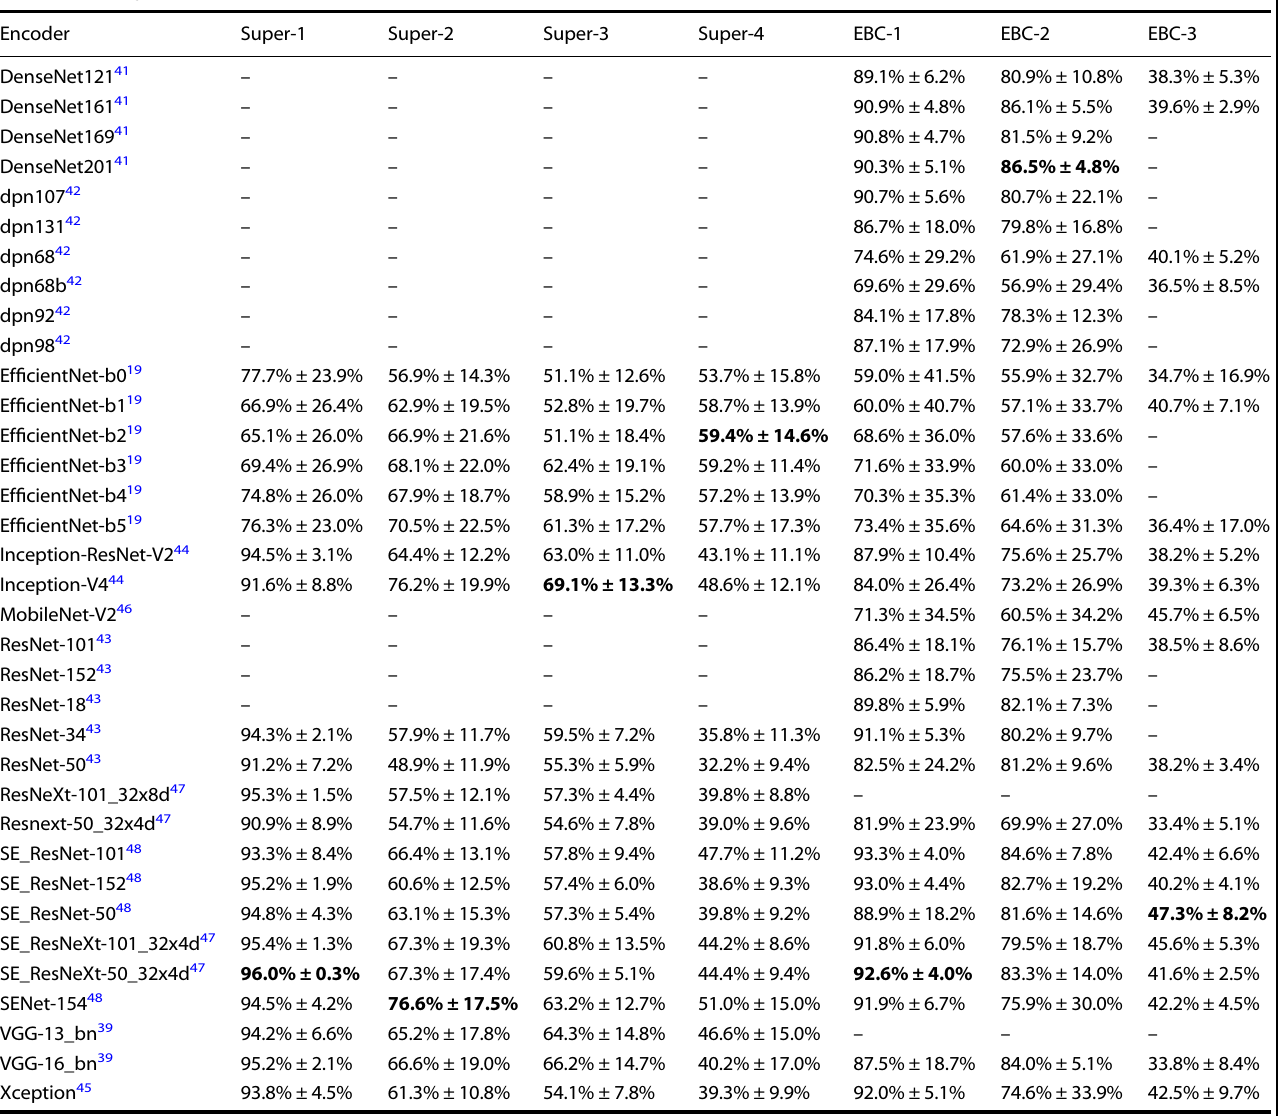
Table 4. Average performance of encoder architectures for each